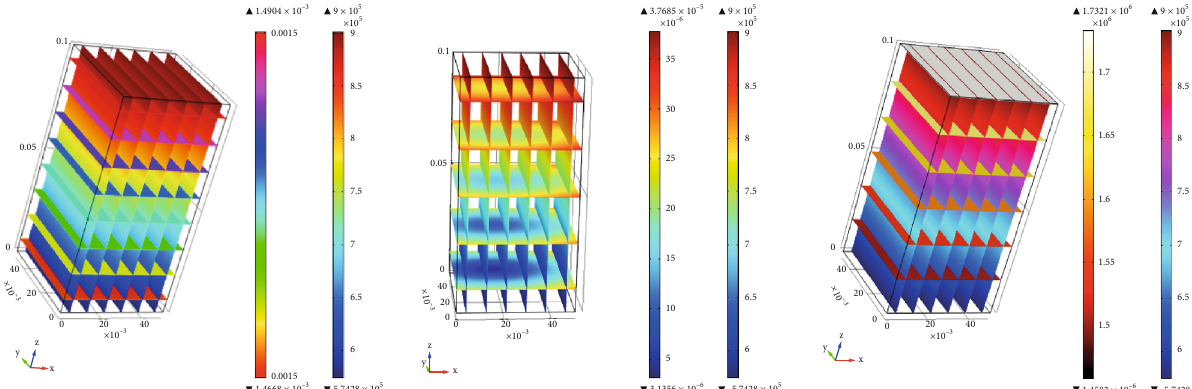
Figure 2: Coupling of pressure fi eld and velocity, displacement, and stress fi eld of gas bearing coal. (1) Pressure fi eld-velocity fi eld. (2) Pressure fi eld-displacement fi eld. (3) Pressure fi eld-stress fi eld.